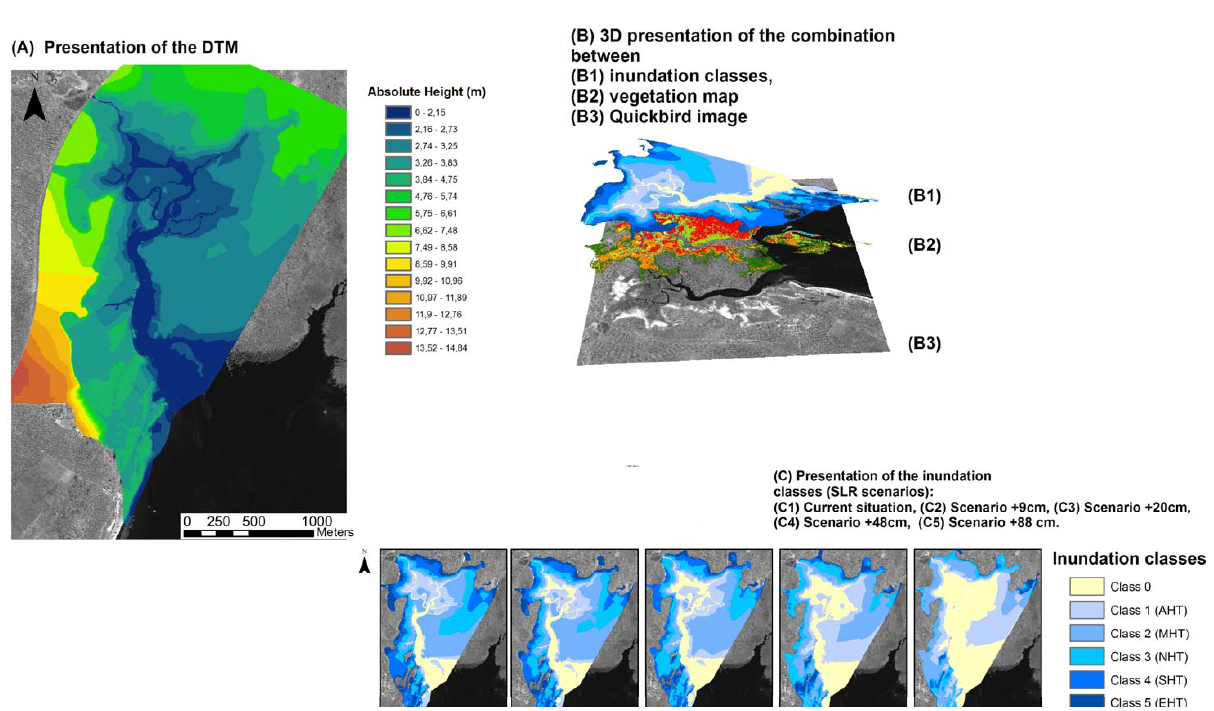
Fig. 2. (A) Presentation of the DTM. (B) 3-D presentation of the combination between (B1) inundation classes, (B2) vegetation map and (B3) QuickBird image. (C) Presentation of the inundation classes: (C1) current situation, (C2) scenario +9cm, (C3) scenario +20cm, (C4) scenario +48cm and (C5) scenario +88cm. AHT stands for all high tides; MHT, medium high tides; NHT, normal high tides; SHT, spring high tides; and EHT, equinoctial high tides. Inundation frequencies higher than those of “class 1” will be referred to as “class 0”.